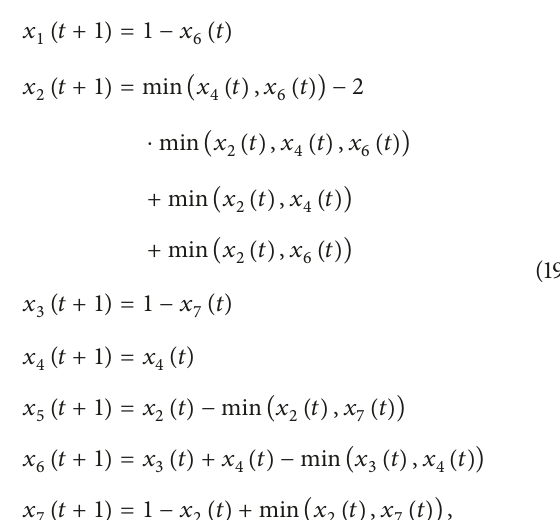
represents a system’s component, and an initial state and a logical function for each node. The states take initial values from the unit interval. Logical functions are validated and transformed into GBPs. The nodes evolve in discrete time, governed by the GBPs. Since the initial states and the GBPs for each node are obtained, IBN can be simulated. The software tool predicts the future behavior of a complex system. After a number of iterations, an attractor is reached, while the dynamics of each node are presented in the graphical